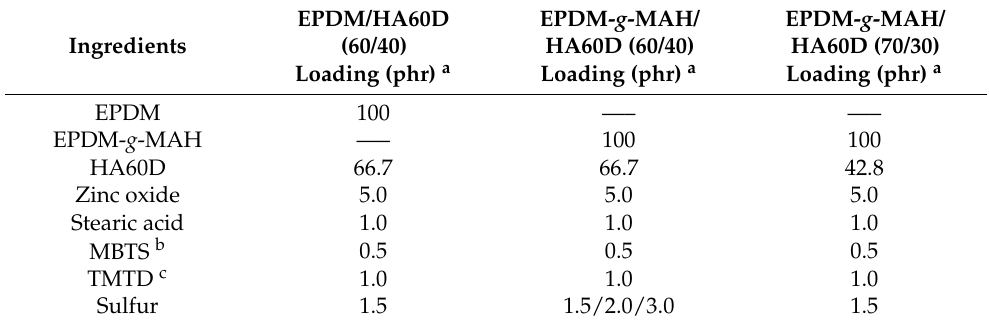
Table 1. The typical compounding formulation for the preparation of thermoplastic vulcanizates.